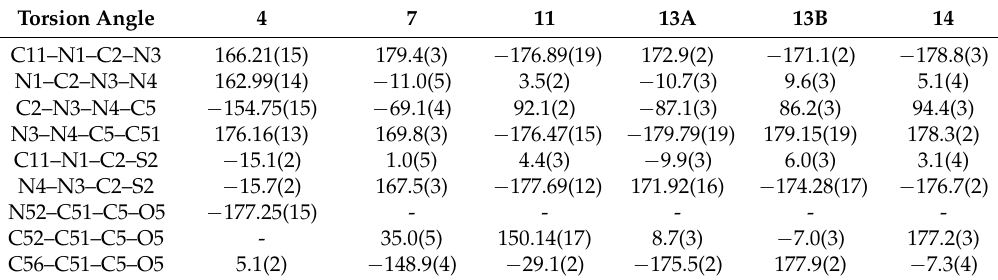
Table 1. Selected torsion angles ( ◦ ) for 4 , 7 , 11 , 13 and 14